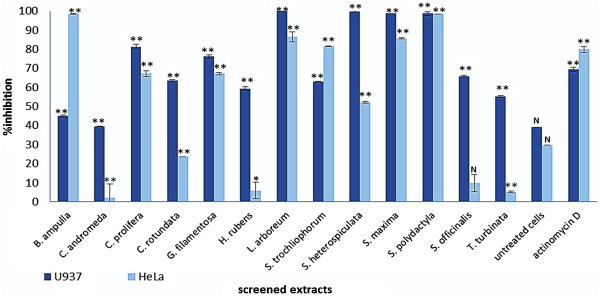
Cytotoxicity of different marine extracts. Samples were dissolved in DMSO and diluted with the medium to a final concentration of 100 μg/ml. Significant differences between the extracts and the DMSO control was calculated using IBM SPPS version 19. **P < 0.00, *P < 0.05 and N indicates not significant.